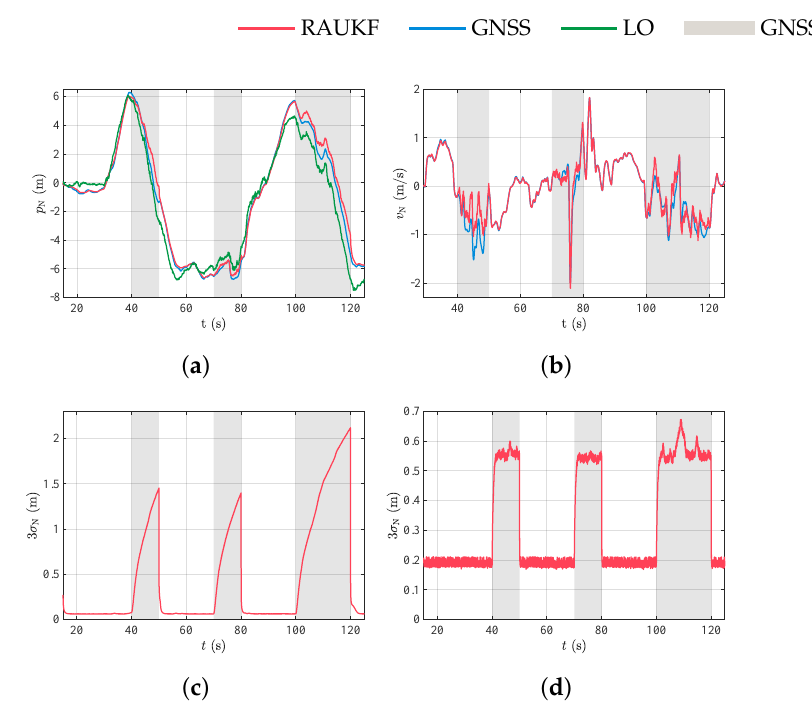
Figure 11. State estimation results. ( a ) Position and ( b ) velocity in the north direction; ( c , d ) three (cid:113) P xx standard deviation σ N = of position and velocity estimates in the north direction. k , ii